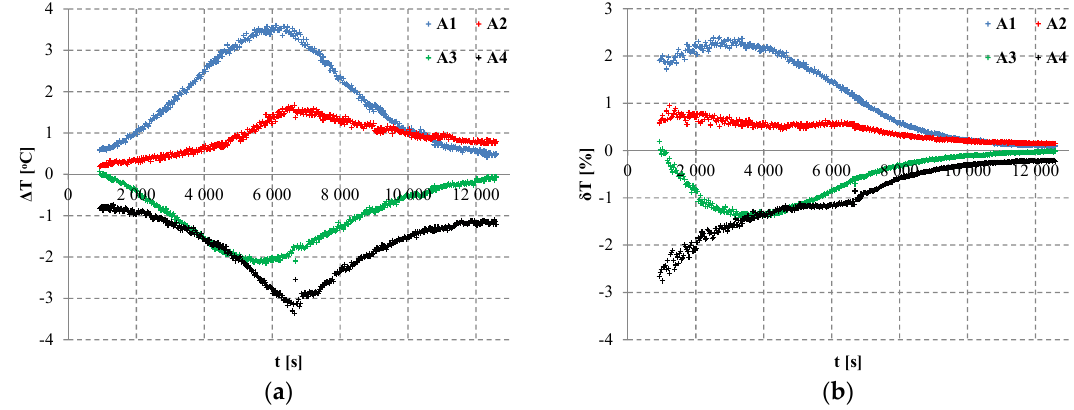
Figure 6. Course of the absolute difference ( a ) and of the relative difference ( b ) for temperature and process p1 in planes A1, A2, A3 and A4.